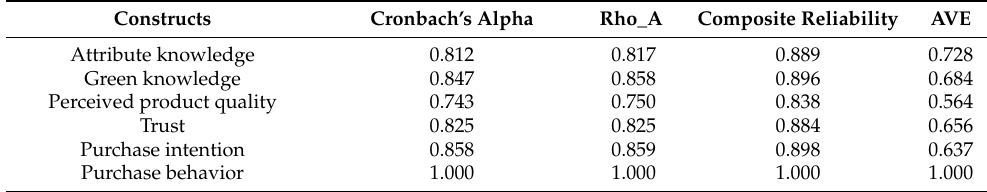
Table 3. Reliability and validity analysis.